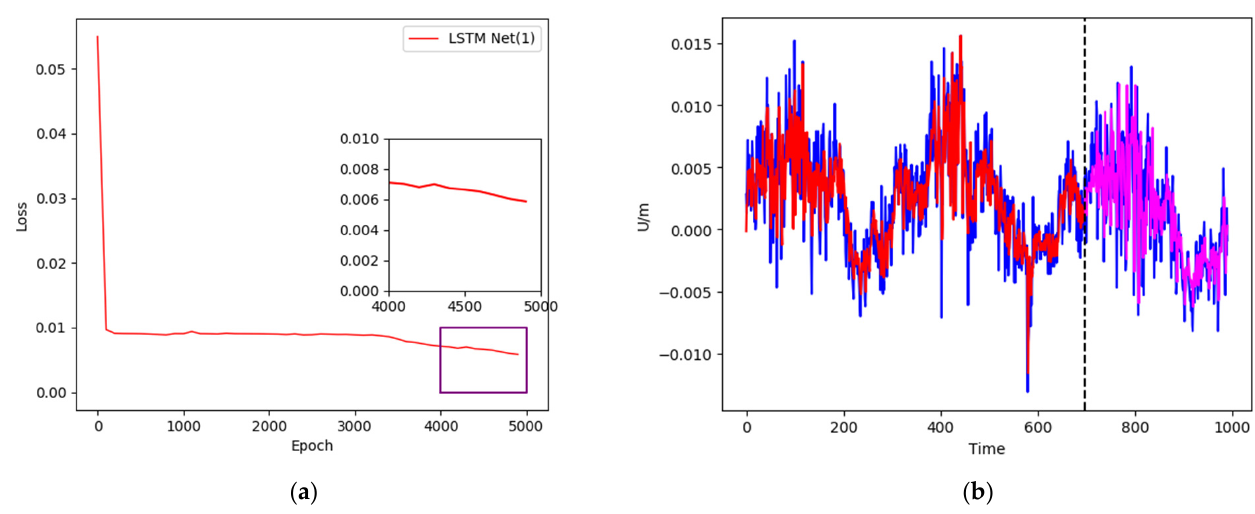
Figure 7. ( a ) Training loss curve; ( b ) data training and prediction of XJSS using LSTM Net(1).